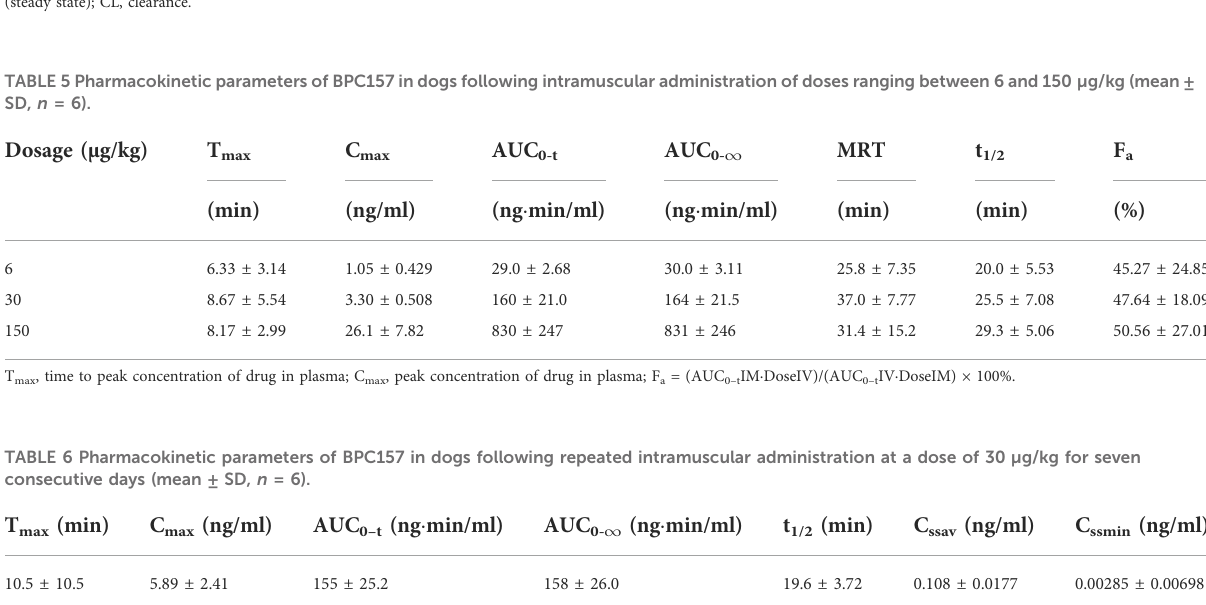
Figure 3D. The corresponding pharmacokinetic parameters are listed as follows: T max = 0.167 h, C max = 155 ± 11.8 ng